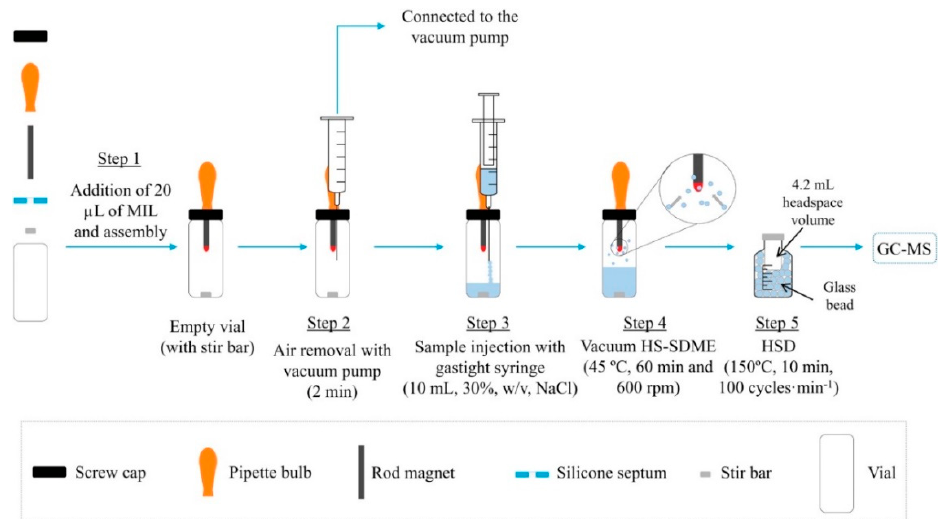
Figure 4. Schematic of the vacuum MIL-HS-SDME procedure under optimum conditions. Reproduced with permission from [51]. Copyright Elsevier, 2017.